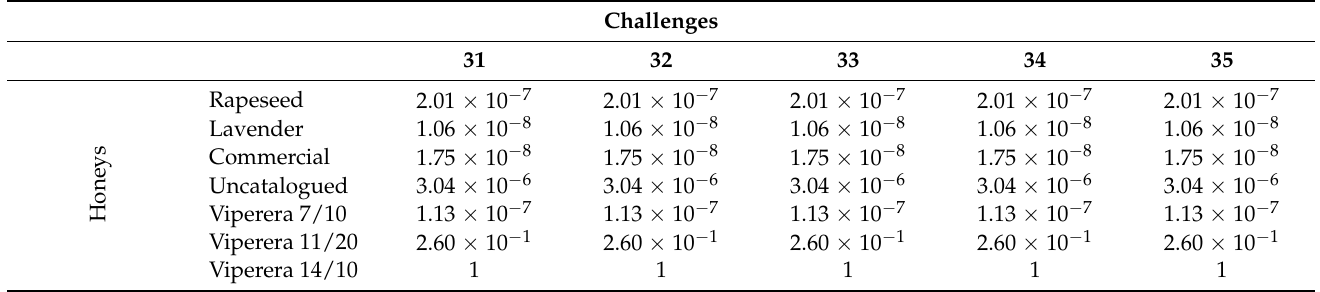
Table 9. Results of the neural network against 35 challenges (from 31 to